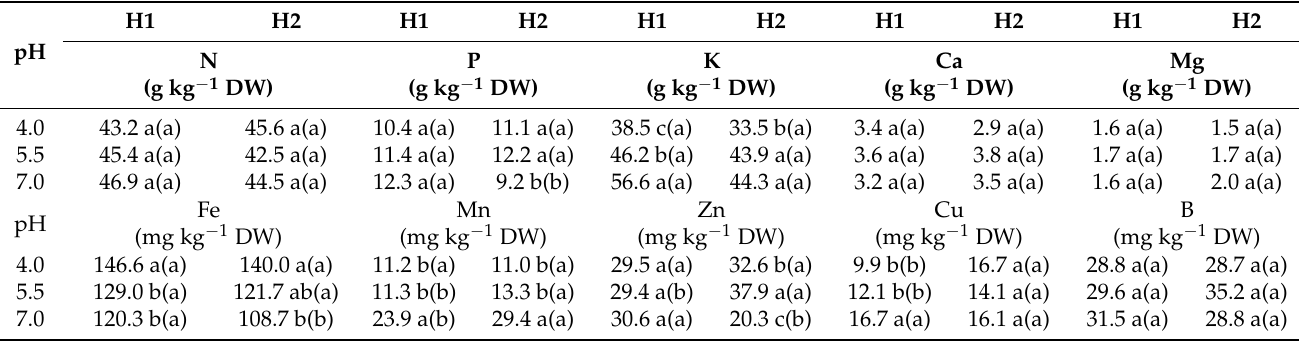
Means in columns followed by the same letter do not differ significantly ( p ≤ 0.05, L.S.D. test). Means in the same row followed by the same letter in parenthesis do not differ significantly ( p ≤ 0.05, T -test). DW: dry weight.